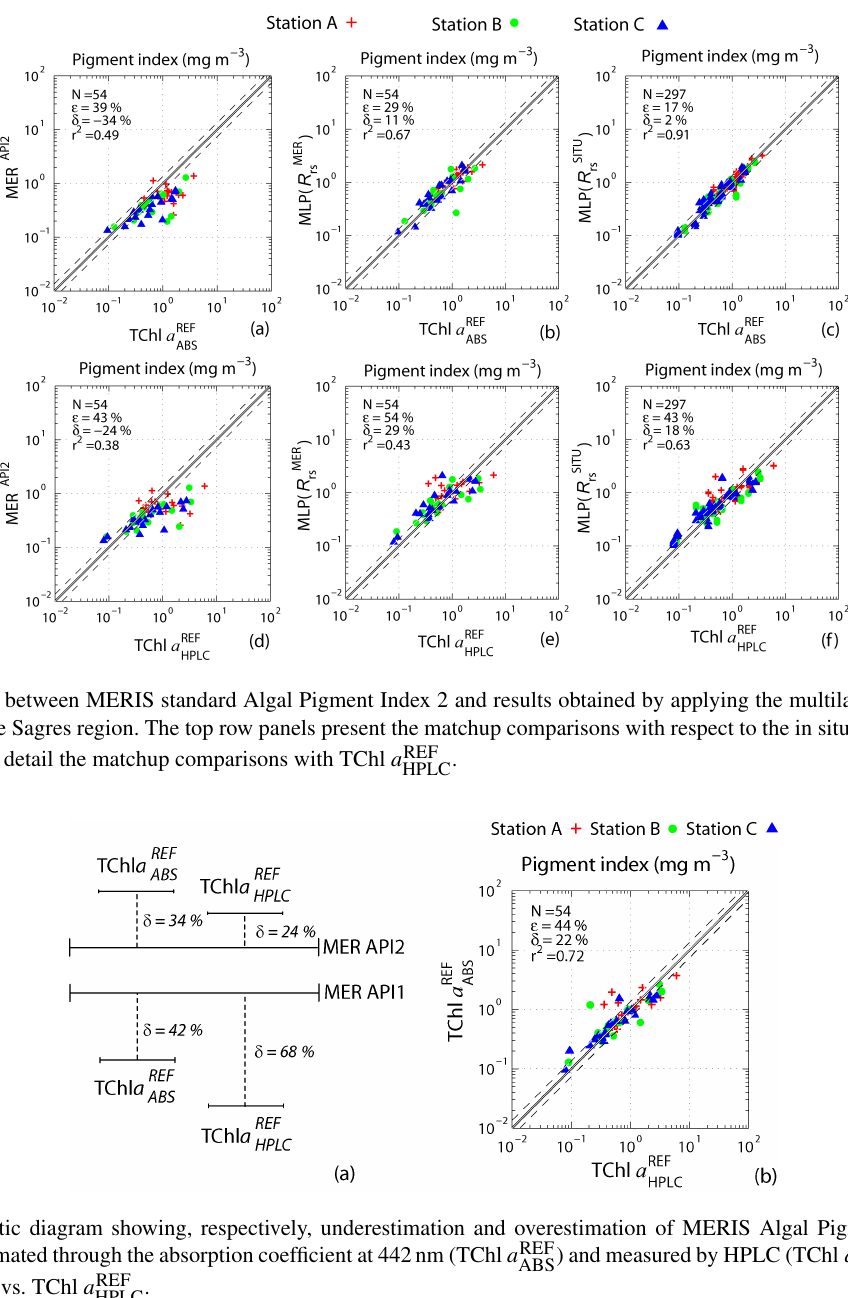
) and measured by HPLC (TChl a REF ), and (b) scatter ABS HPLC